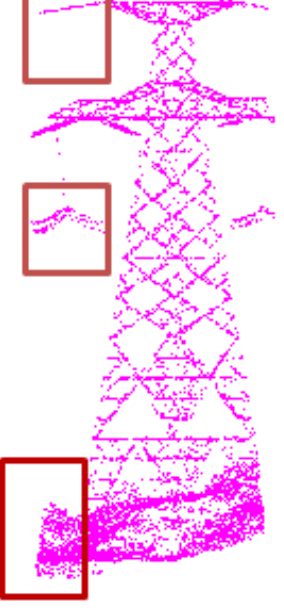
Figure 3. Noise points of transmission tower.